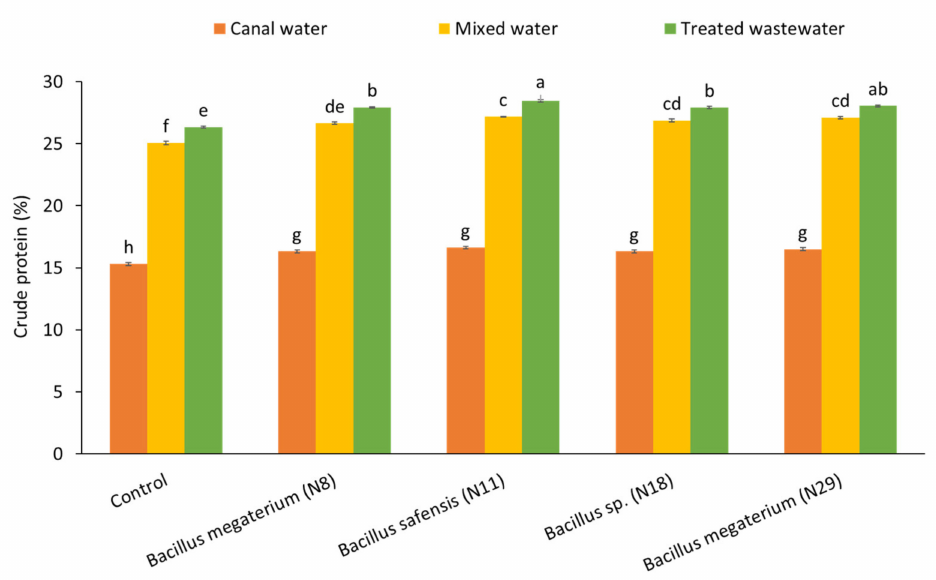
Figure 3. Effect of Pb-tolerant Bacillus strains on protein contents of spinach plants under wastewater, mixed water, canal water conditions in pot trial; ( n = 4); Bars sharing different letters are statistically significant from each other at 5% level of